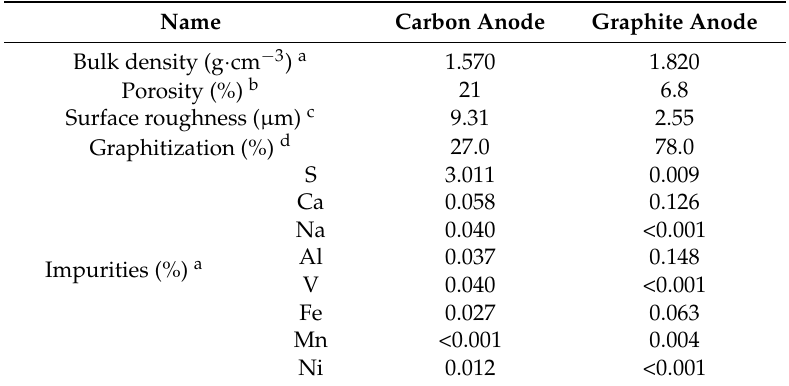
Table 1. Physicochemical properties of the carbon and graphite